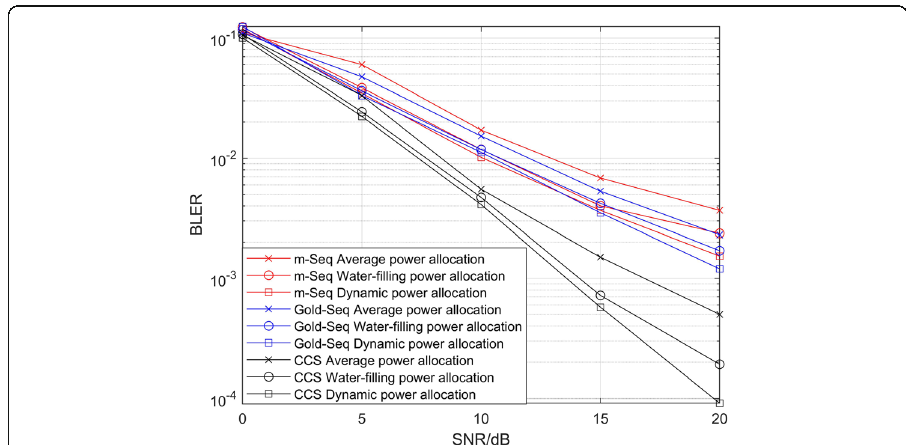
Fig. 13 Performance comparison of several power allocation algorithms under three spreading sequences. The performance comparison of three power allocation under three spread spectrum sequences. The dimension of pattern matrix is 2 (cid:5)